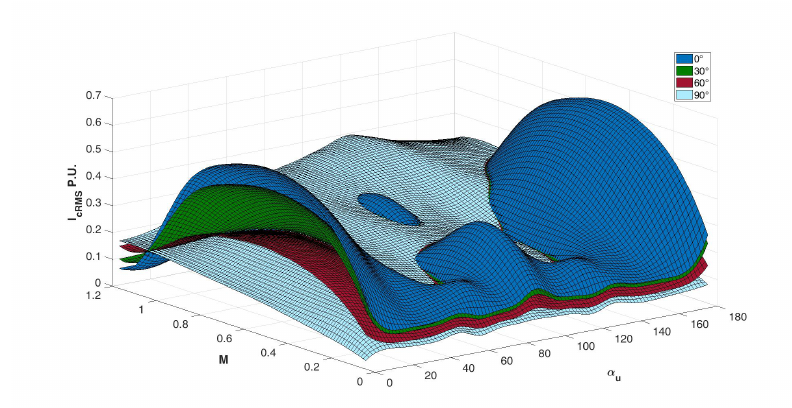
Figure 10. Simulated results: triple-3-phase phase machine: values of I C and α u . Each surface represents a different value of VI-phase.